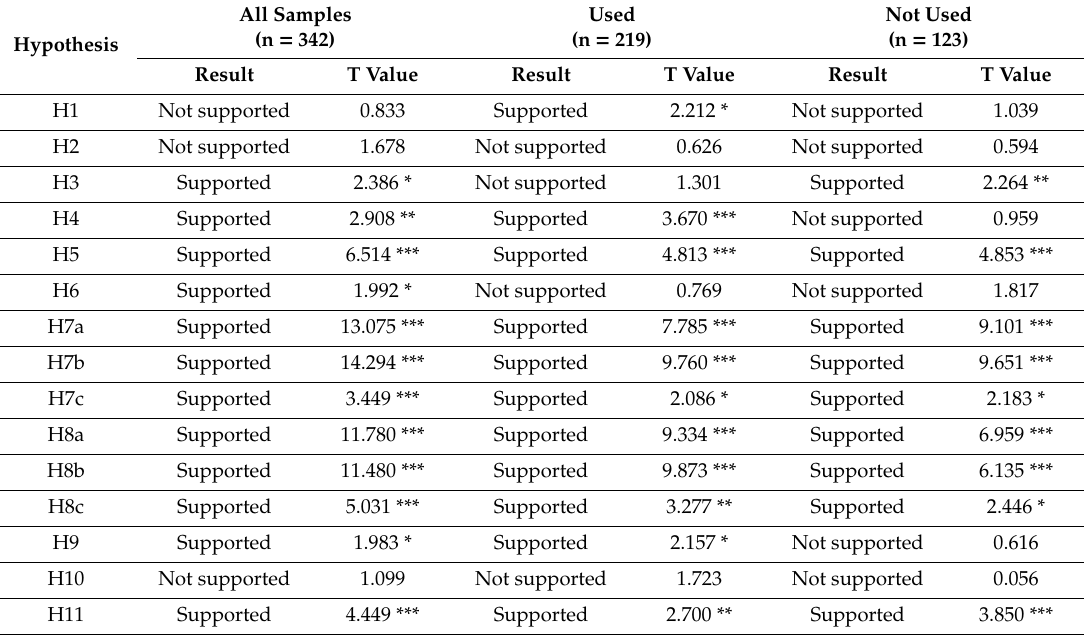
Table 4. Research hypothesis